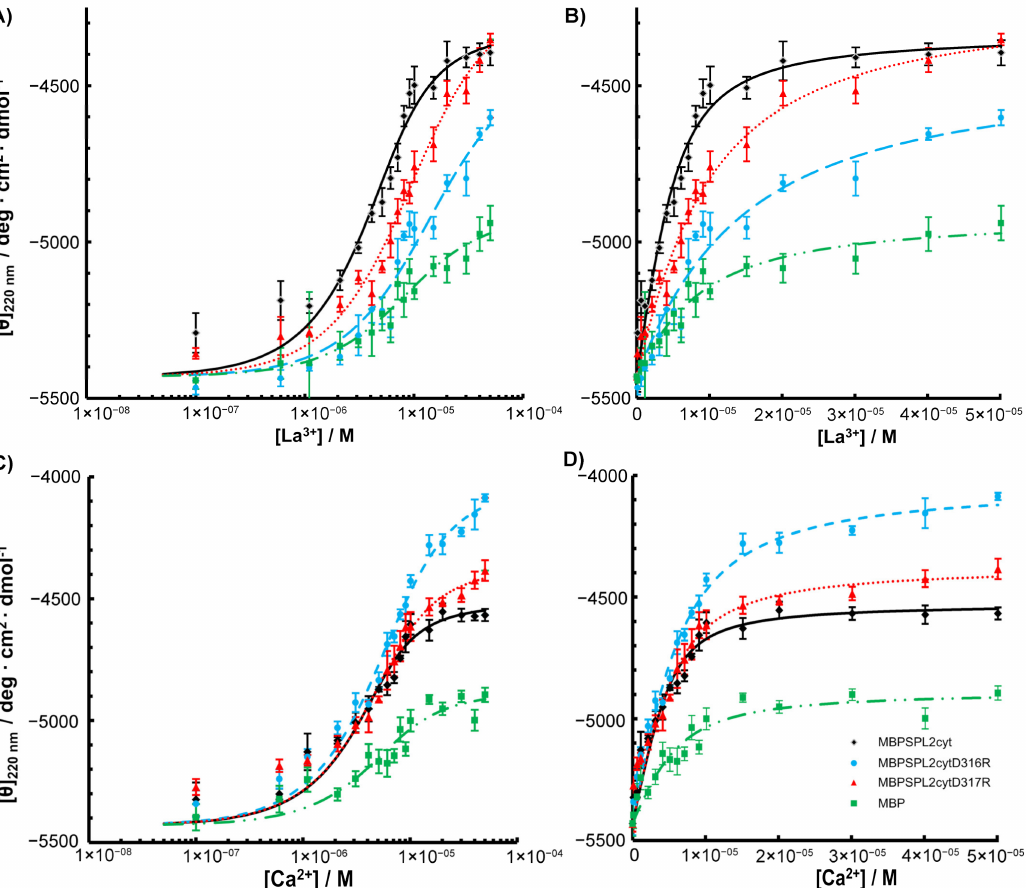
Figure 4. ( A ) La 3+ and ( C ) Ca 2+ titrations of MBP-SPL2cyt (black) and its mutants (MBP-SPL2cytD316R (blue), MBP- SPL2cytD317R (red)) measured by spectrapolarimetry. ( B , D ) Binding titrations of La 3+ and Ca 2+ , respectively, plotted with a linear